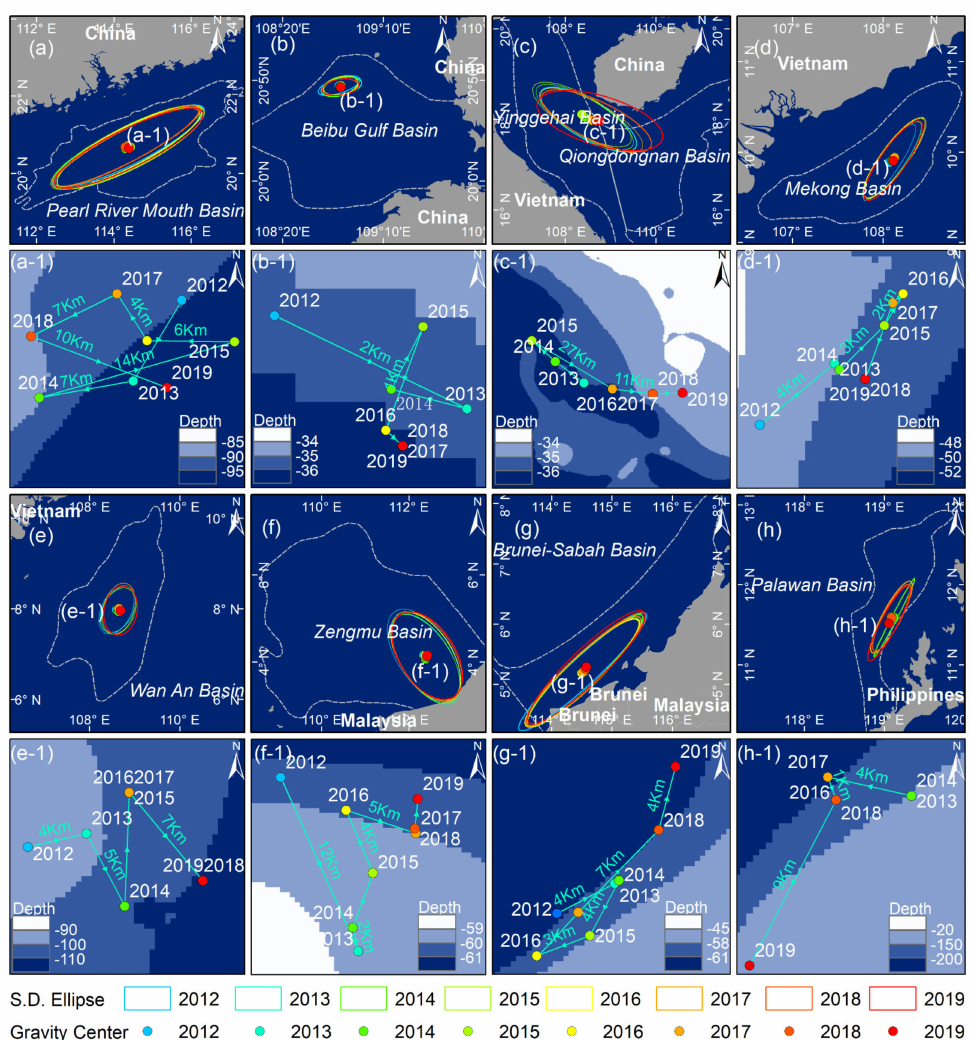
Figure 15. Gravity center shift of offshore HE targets distribution in each basin from 2012 to 2019. ( a – h ) are the GCHETDs and standard deviation ellipses in each basin respectively; ( a-1 – h-1 ) are the corresponding shift paths of the GCHETDs in each basin